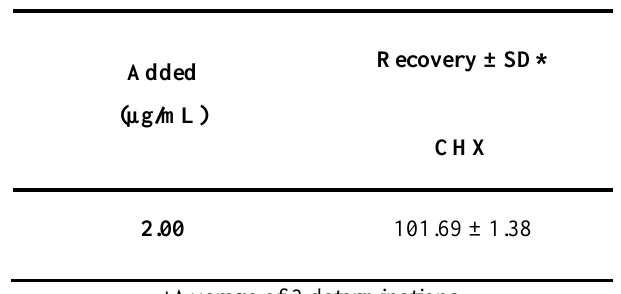
Table 7. Application of the proposed HPLC method for determination of CHX in spiked human saliva: